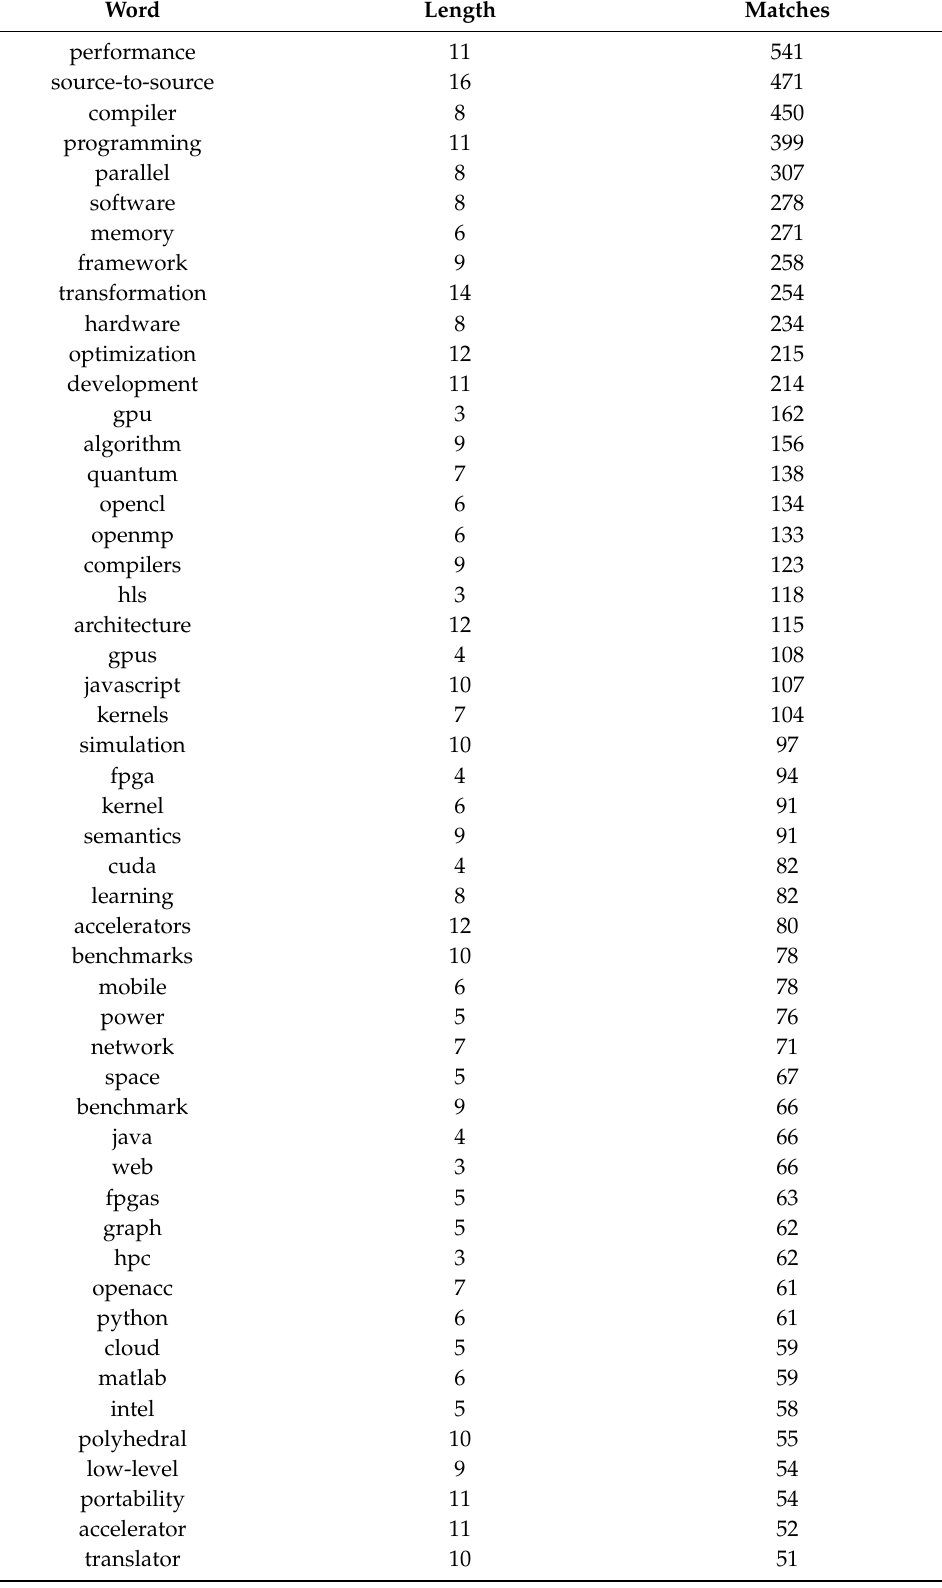
Table 5. Terms extracted from the word list